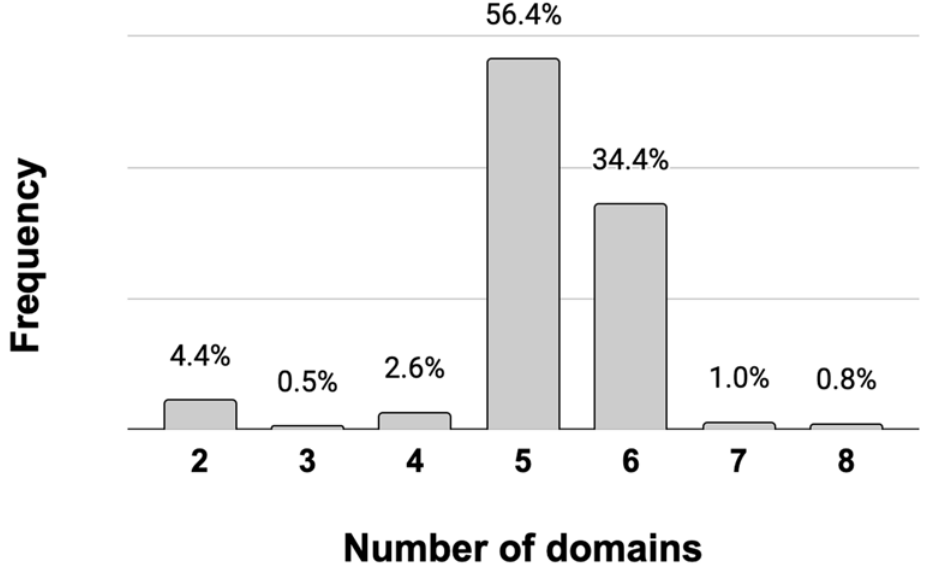
Figure 1. Frequency of multi-domain structures of the EPSPS in fungi. There are 390 out of 420 EPSPS proteins with multi-domain structure in fungi. The majority of these proteins have five or six domains.